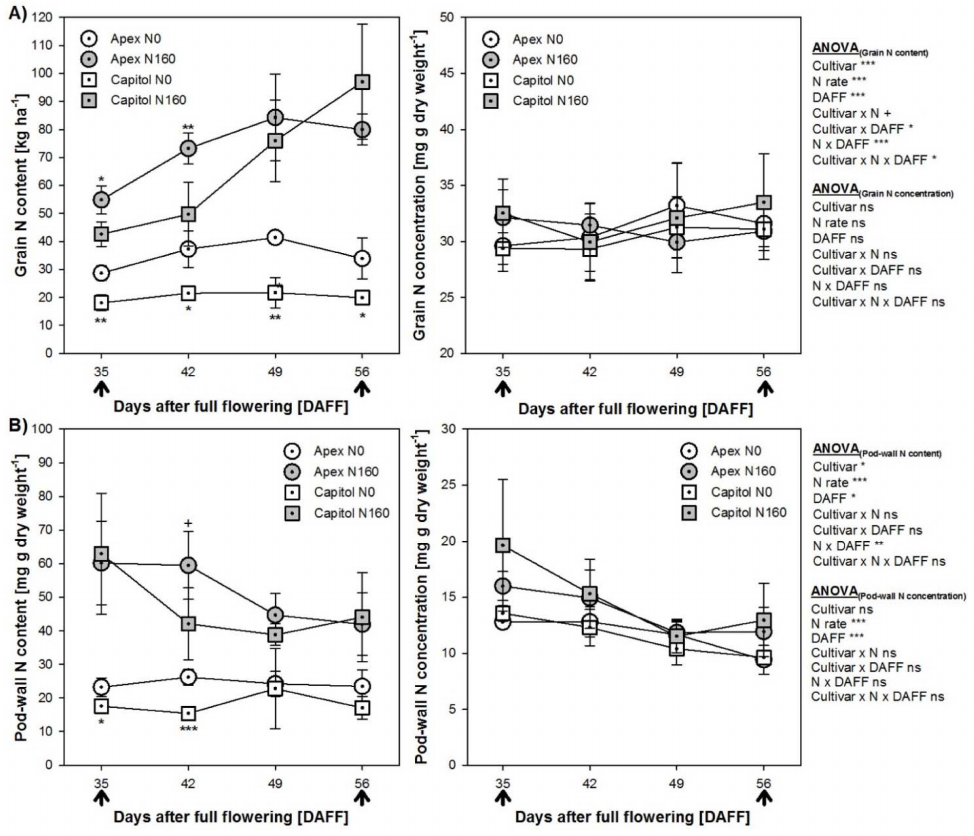
Figure 6. Nitrogen contents ( left ) and concentrations ( right ) of the ( A ) grain and ( B ) pod wall from all pods having reached the cultivar-specific size until maturity of the winter oilseed-rape line-cultivars Apex and Capitol as affected by N fertilization rate (N0 and N160). The arrows indicate the developmental stages BBCH79 and BBCH89. ANOVA: +, * , ** , and *** indicate significant differences at p < 0.10, p < 0.05, p < 0.01, and p < 0.001, respectively. ns = non-significant. Individual DAFF: +, * , ** , and *** indicate significant differences between the cultivars within the N fertilization rates at p < 0.10, p < 0.05, p < 0.01, and p < 0.001, respectively. The error bars (visible only when greater